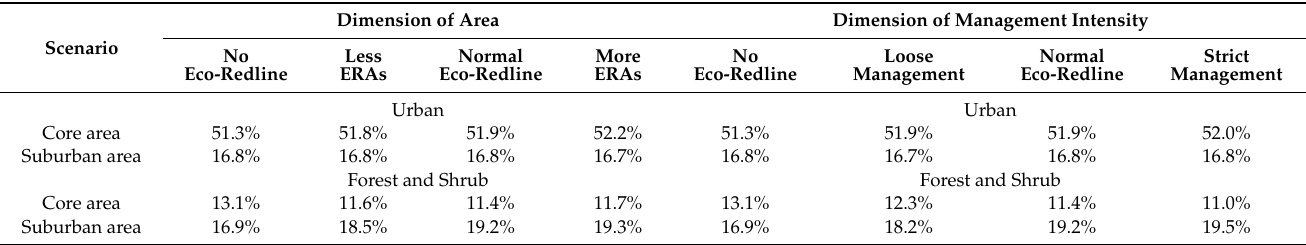
Figure 8. Division of 9 districts in core area and suburban area (core area: Yuzhong, Dadukou, Jiangbei, Shapingba, Jiulongpo, and Nan’an; suburban area: Beibei, Yubei, and Ba’nan). Table 12. The percentages of urban areas and sum of forest and shrub areas of different scenarios in 2050 from the dimension of area and management intensity.